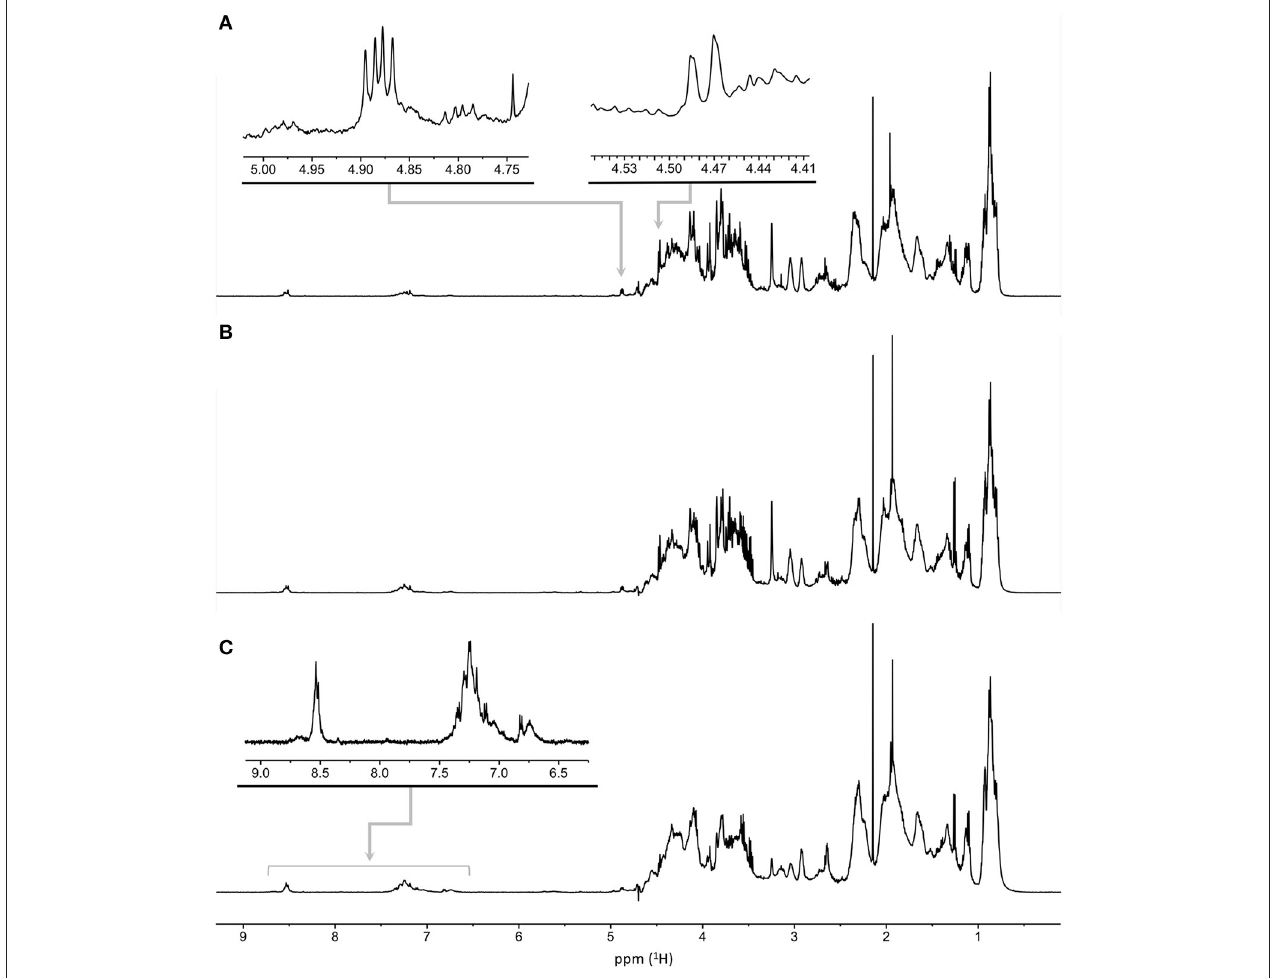
FIGURE 6 | Water-suppressed 1 H NMR spectra of melanoidins from DL produced at pH i of 6.5 (A) , 7.0 (B) , and 7.5 (C) . The spectral regions employed in the estimation of chemical group ratios are